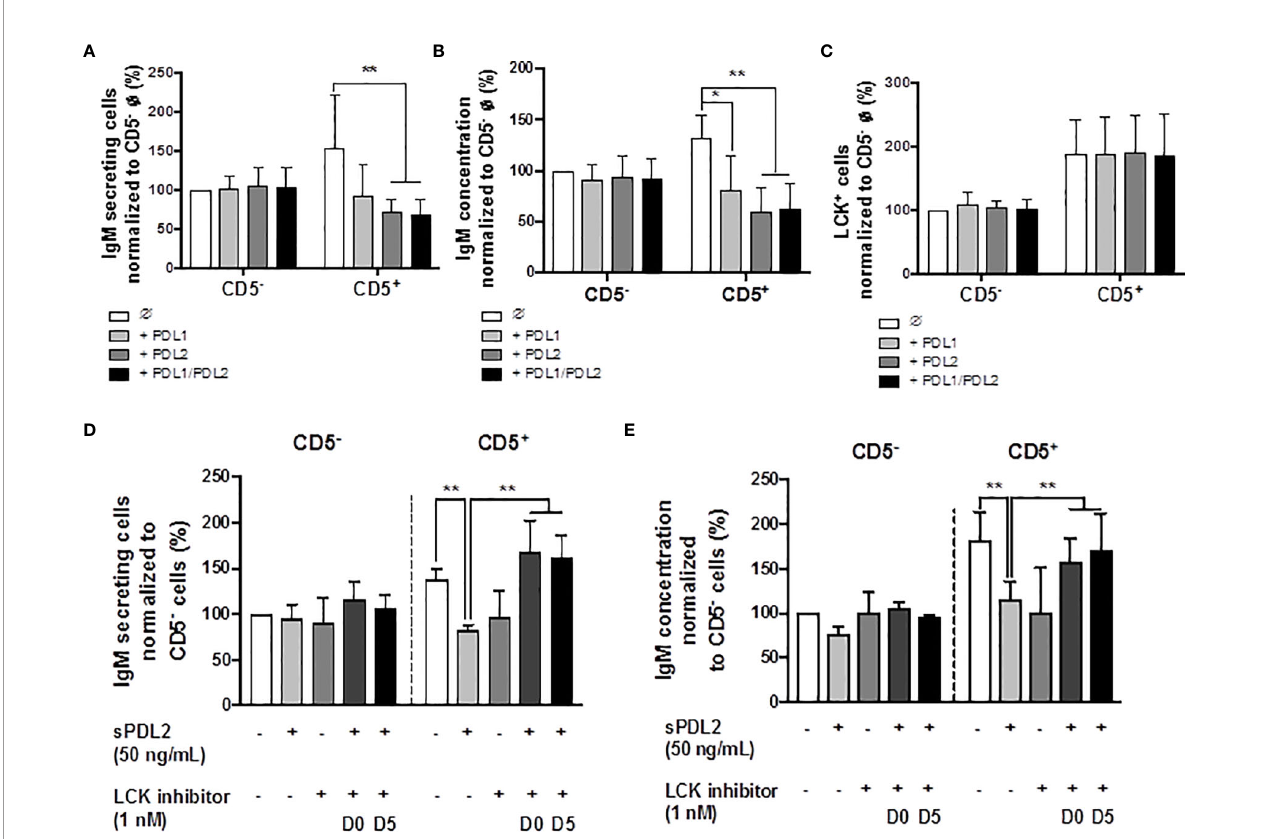
FIGURE 6 | Treatment with soluble PD-1 ligands (PDL1 and PDL2) suppressed the IgM response and LCK inhibitor treatment blocked PD-1-mediated IgM suppression in CD5 + ILBs. Human CD5 +/- B cells were activated as previously described and treated with soluble PD-L1, PD-L2 or the combination of both on day 0 and cultured for 7 days. LCK inhibitor (RK24466) was provided on day 0 or day 5 to the cell culture. (A) Averaged ELIspot data showing the number of IgM secreting cells; (B) Averaged IgM concentration from culture supernatants; (C) Averaged frequency of LCK + cells within CD5 +/- populations on day 7; (D) Averaged number of IgM secreting cells; and (E) Averaged IgM concentration from CD5 +/- culture supernatants with PDL2 and LCK inhibitor treatments. Determinations were made using B cells from 6 human donors (N = 6) across two independent experiments. For (A – C) , data presented in the fi gure were normalized to CD5 - B cells without PD-1 ligand treatment. For (D, E) , results were normalized to CD5 − B cells without PDL2 or LCK inhibitor treatment. Signi fi cant differences are indicated by * p < 0.05 and ** p < 0.01 (two-way ANOVA following with Fisher ’ s LSD post hoc